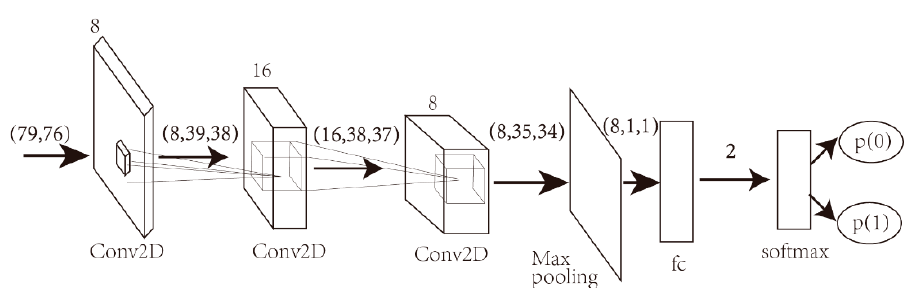
Figure 4. Block diagram of the CNN model